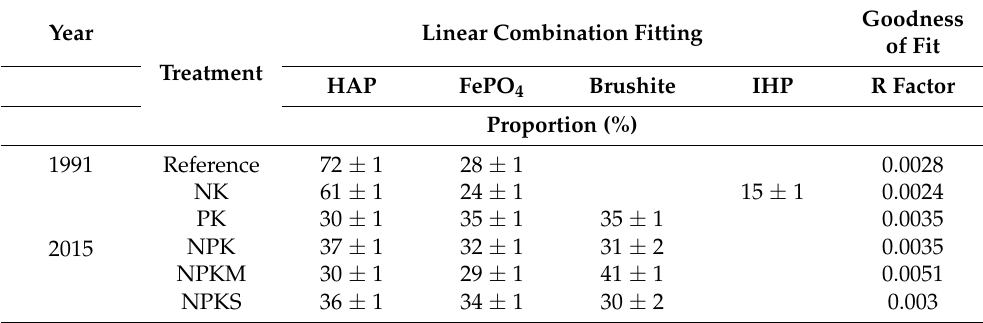
Table 3. Linear combination fitting of P K-edge XANES spectra of soils under different fertiliza- tion